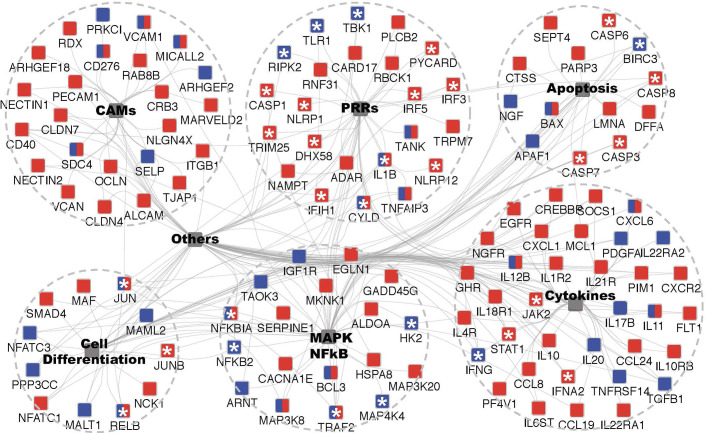
GO enrichment analysis of microbe-associated molecular pattern (MAMP) up-regulated DEGs to identify underpinned functional pathways in activating the cod macrophage inflammatory response. GO enrichment and network visualization was conducted by Cytoscape plugin ClueGO and CluePedia. Cod up-regulated DEGs annotated to human SwissProt identifiers were mapped to KEGG (Kyoto Encyclopedia of Genes and Genomes) pathways database. Enriched KEGG terms that are shared the same cluster were collapsed into one integrative node (shaded grey) labelled with brief descriptions respectively (See Figure S5 and Dataset S1 for the full network). Six major inflammation-related functional pathways were shown, and the remaining ones were labelled with “Others”. The associated DEGs with indicated KEGG pathways were color coded in a MAMP-dependent fashion, red and blue nodes denote dsRNA- and uPGN-responsive genes, respectively; whilst the dual-labelled nodes denote the common DEGs that are responsive to both MAMPs. Asterisks indicate genes that serve as key sensors, adaptors or regulators in mediating inflammatory response and had been intensively discussed in texts.